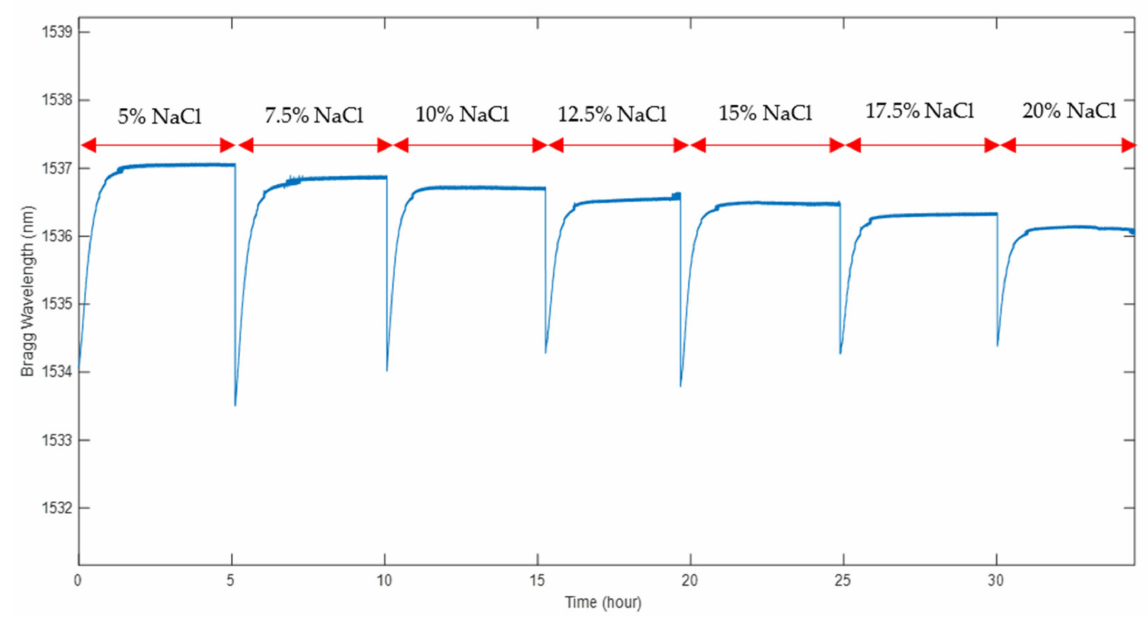
Figure 13. The sensor’s response to salinity variations at a constant SWC of 15%.